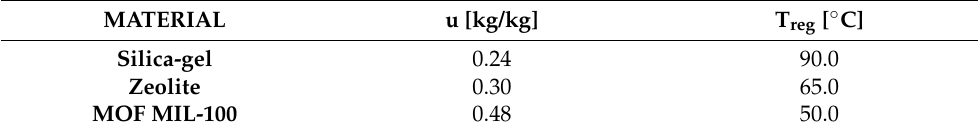
Table 5. Uptake and regeneration characteristics of the material under